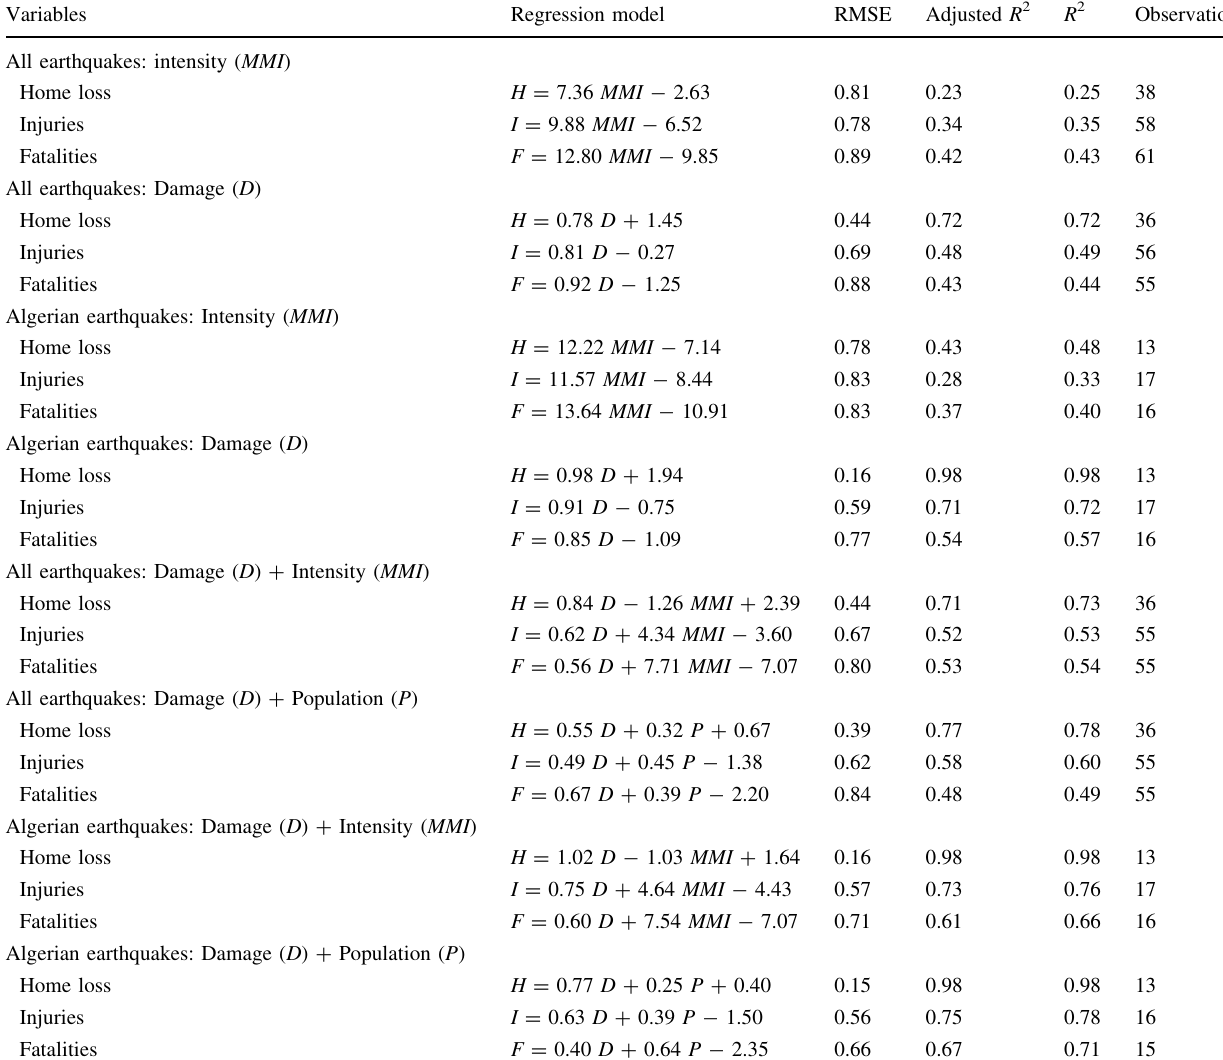
Table 7 Regression of the home loss ( H ), injuries ( I ), and fatalities ( F ) variables as human loss parameters using damage ( D 4 ? D 5), intensity ( MMI ), and population affected ( POP.Unit ) as the predictor Variables Regression